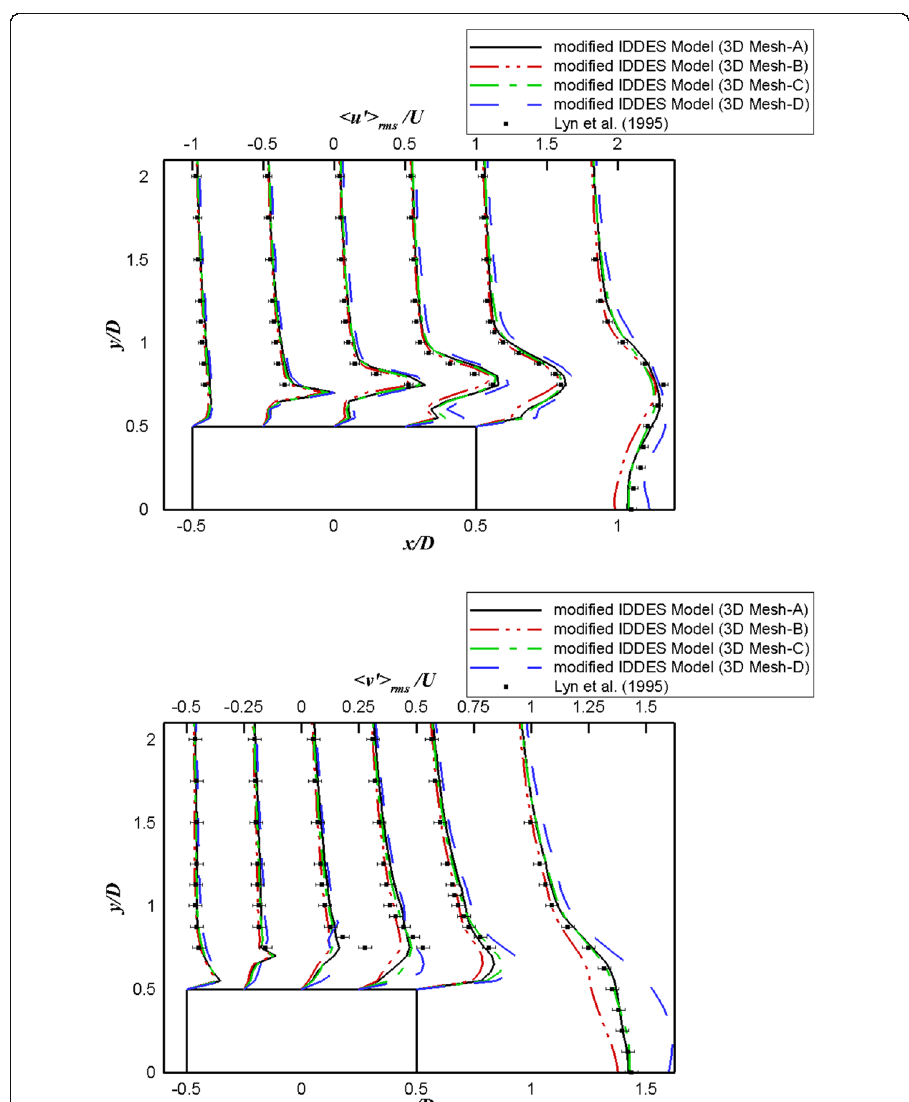
Fig. 14 rms streamwise (top) and cross-stream (bottom) velocity fluctuations at different locations before wake predicted by 3D simulations with the modified IDDES